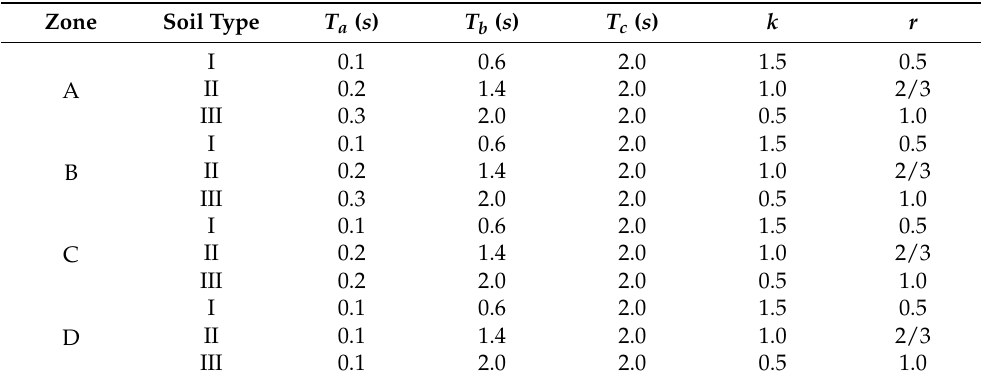
Table 8. Values of periods and exponents for the elastic design spectrum, reproduced with